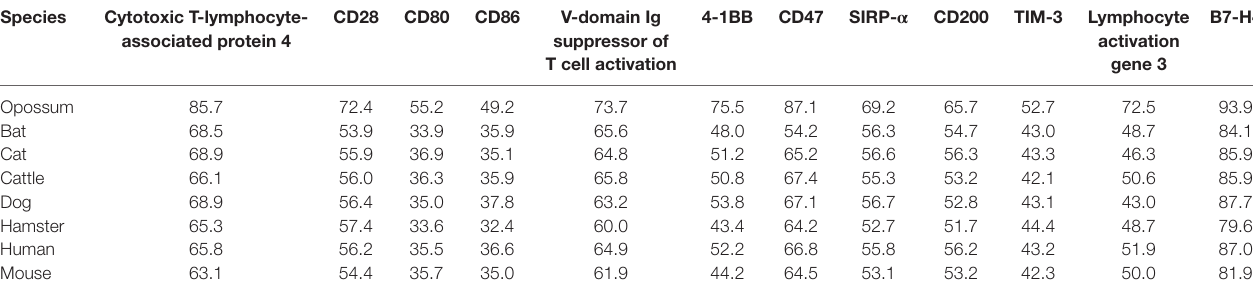
Percent identity was calculated by Clustal 2.1